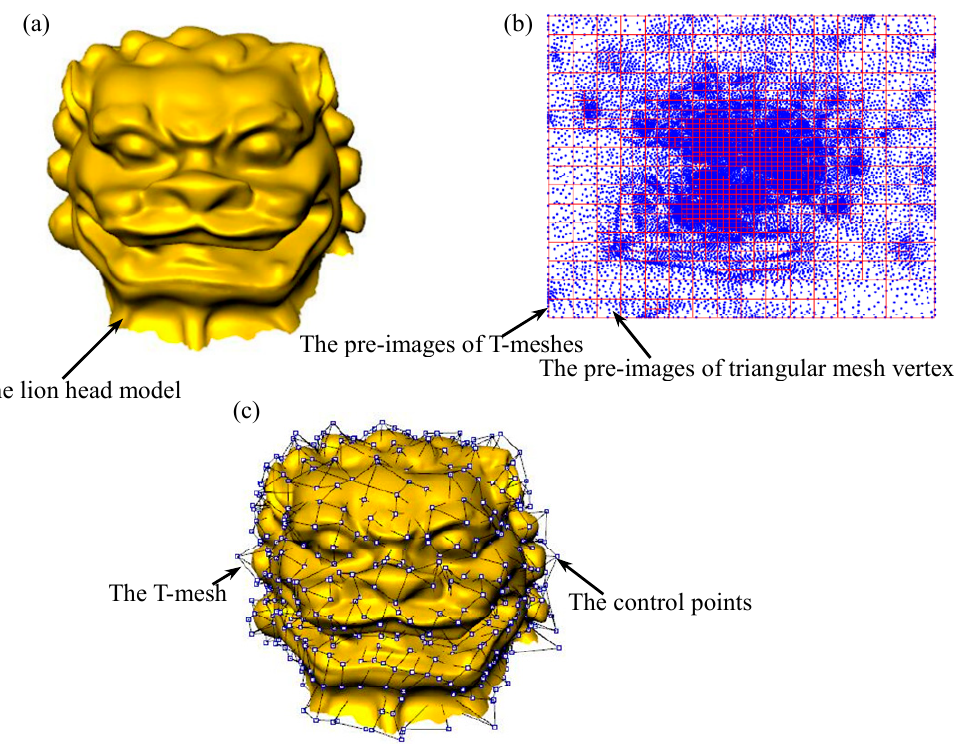
Figure 8. Chinese lion head model as an example of fitting T-splines, ( a ) the original lion head model, ( b ) the pre-image of T-meshes and triangle mesh vertexes, ( c ) the spatial distribution of control points and T-meshes.